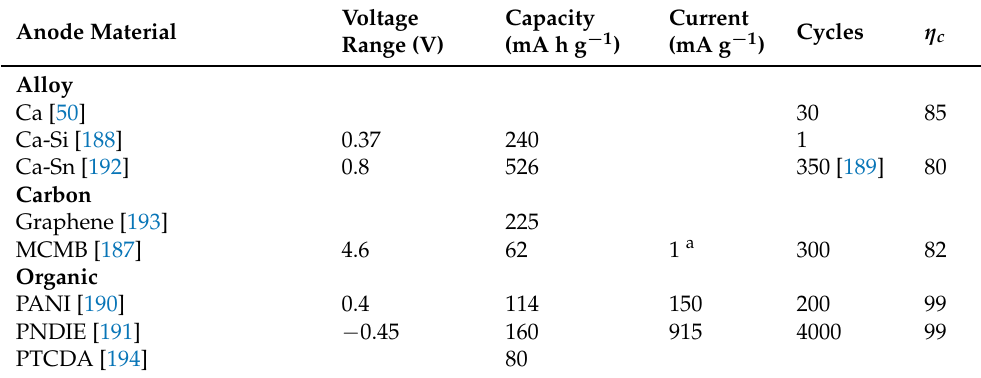
Table 6. Anode materials for Ca-based